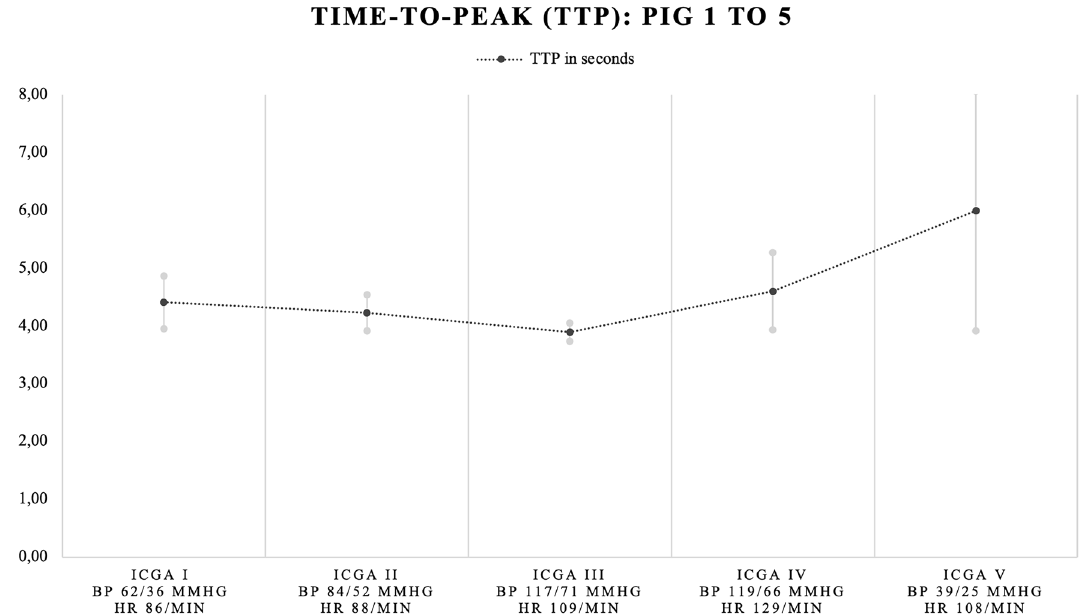
Figure 3. Mean time-to-peak (TTP) in seconds for all 5 pigs. Mean TTP (in black) with standard deviations (in grey). X-axis: ICGA assessment number, mean BP and HR for all pigs. Y-axis: mean TTP in seconds. ICGA indocyanine green angiography (I = baseline, II = after norepinephrine (NE) dose 1, III = after NE dose 2, IV = after NE dose 3, V = remnant measurement following discontinuation of NE), BP = blood pressure, HR = heart rate.